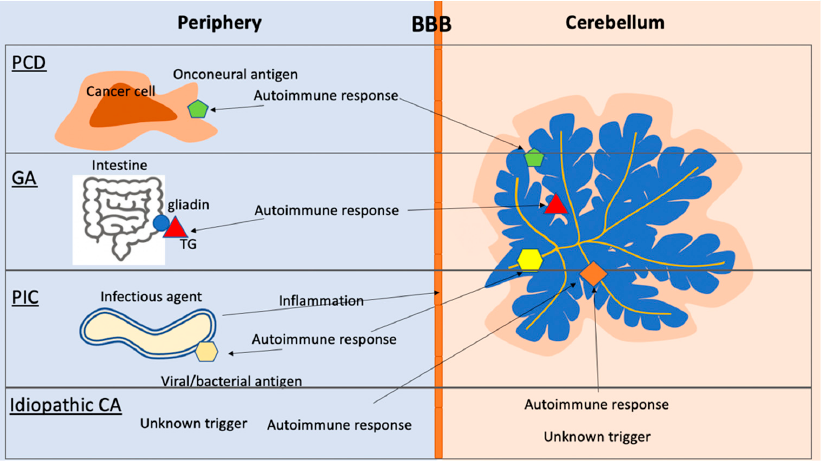
Figure 3. Autoimmune cerebellar diseases. PCD: the onconeural antigen expressed on the cancer cells triggers an autoimmune response, which can recognize the same antigen in the cerebellum. PIC: The infectious agent evokes an immune response to an antigen that bears similarity to a neural antigen (mimicry). The infection also causes an inflammatory response, which compromises the BBB, allowing antibodies and immune cells access to the CNS. GA: Autoimmune response to the TG-gliadin complex results in TG-specific autoantibodies. TG autoantibodies can recognize brain-specific TGs. Idiopathic CA: the triggering event resulting in the autoimmune response is unclear. The trigger may occur in the periphery or in the CNS.